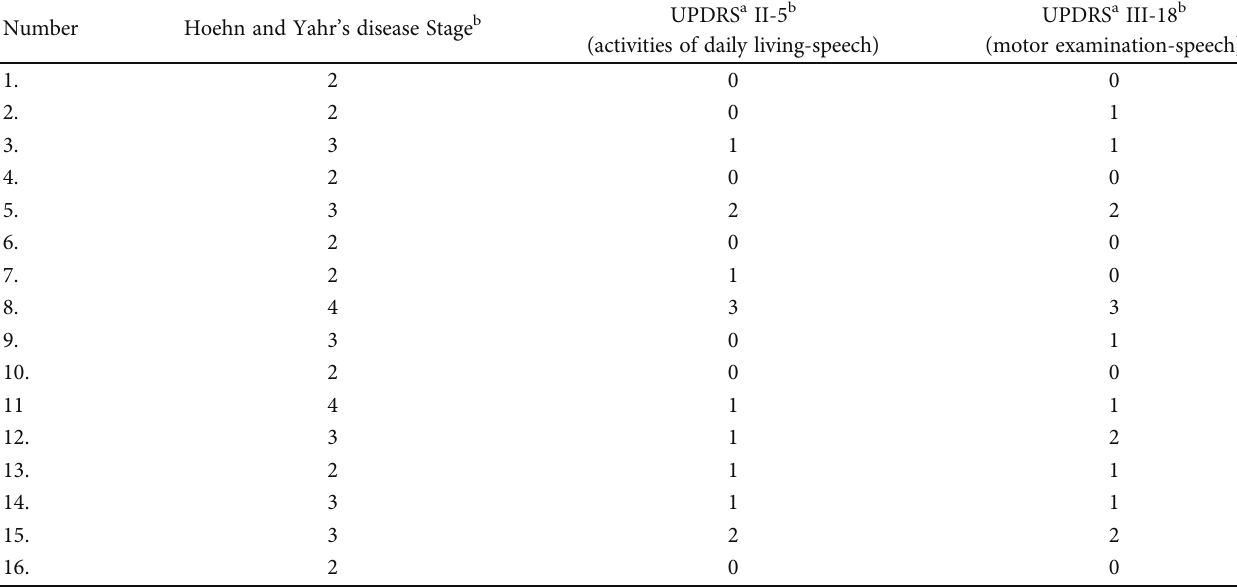
Table 1: The demographics of the PD participants included in the